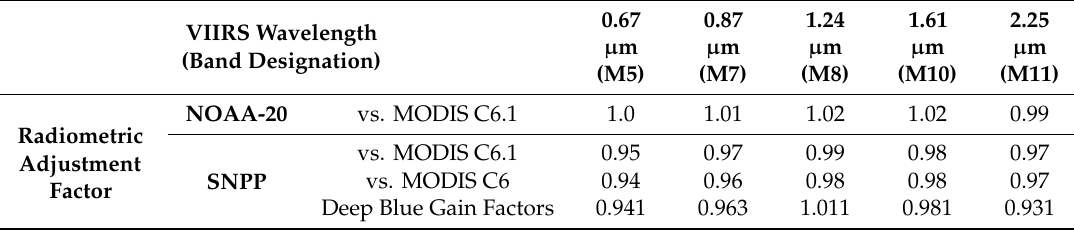
Table 2. Shortwave radiometric adjustment factors derived for SNPP and NOAA-20 VIIRS,